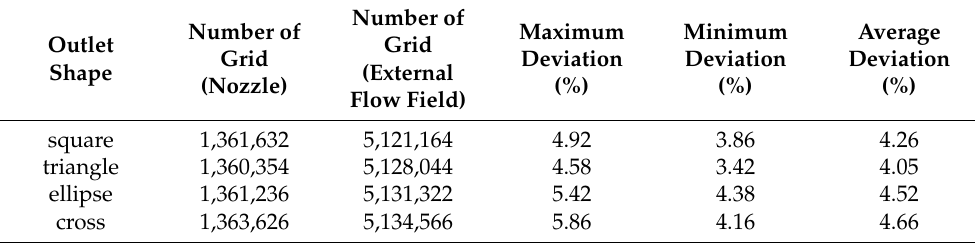
Table 5. Error analysis of numerical simulation and experimental results of the other